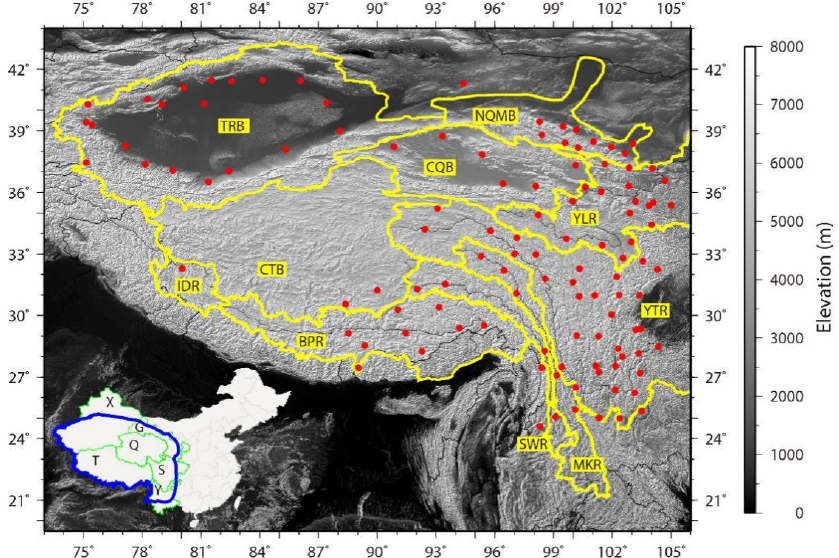
Figure 1. The geographic locations of the study area and the weather stations on the Tibetan Plateau and the surroundings (TPS) used in the study. The blue line in the inset represents the study area and green lines represent the boundaries of the 6 provinces including the Tibet Autonomous Region (T), Qinghai Province (Q), Xinjiang Uygur Autonomous Region (X), Gansu Province (G), Sichuan Province (S), and Yunnan Province (Y). Red points denote the weather stations. Yellow lines represent the boundaries of the ten basins on the TPS: The Yellow River basin (YLR), the Yangtze River basin (YTR), the Mekong River basin (MKR), the Salween River basin (SWR), the Brahmaputra river basin (BPR), the Indus River basin (IDR), the Tarim River basin (TRB), the Northern Qilian Mountain river basin (NQMB), the Changtang Basin (CTB), and the Chaidamu and Qinghai Lake basins (CQB) in the interior TPS.